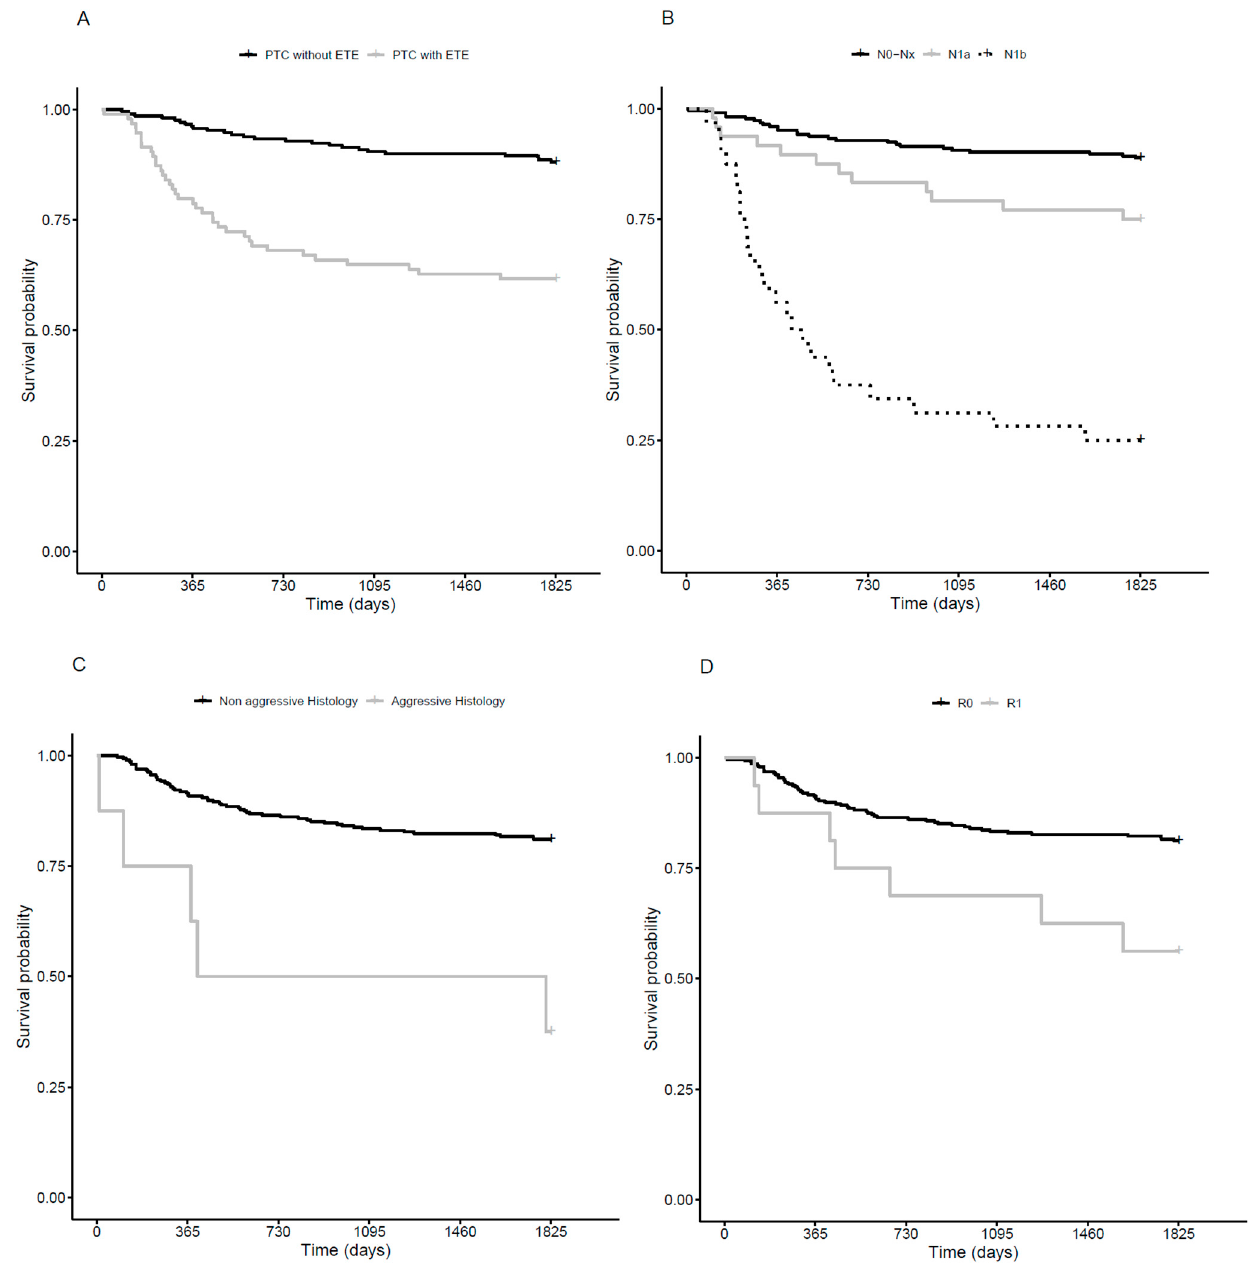
Figure 1. Univariate analysis (Kaplan-Meier analysis). ( A ). Recurrence-free survival (RFS) in patients with mETE vs. no mETE. ( B ). RFS in patients with aggressive histology vs. no aggressive histology carcinoma. ( C ). RFS in patients with pathological margin resection (R1) vs. no pathological margin resection. ( D ). RFS in patients with LNI (N1b or N1a) vs. no LNI (N0-Nx). Table 2. Multivariate analysis of factors associated with a subsequent treatment.